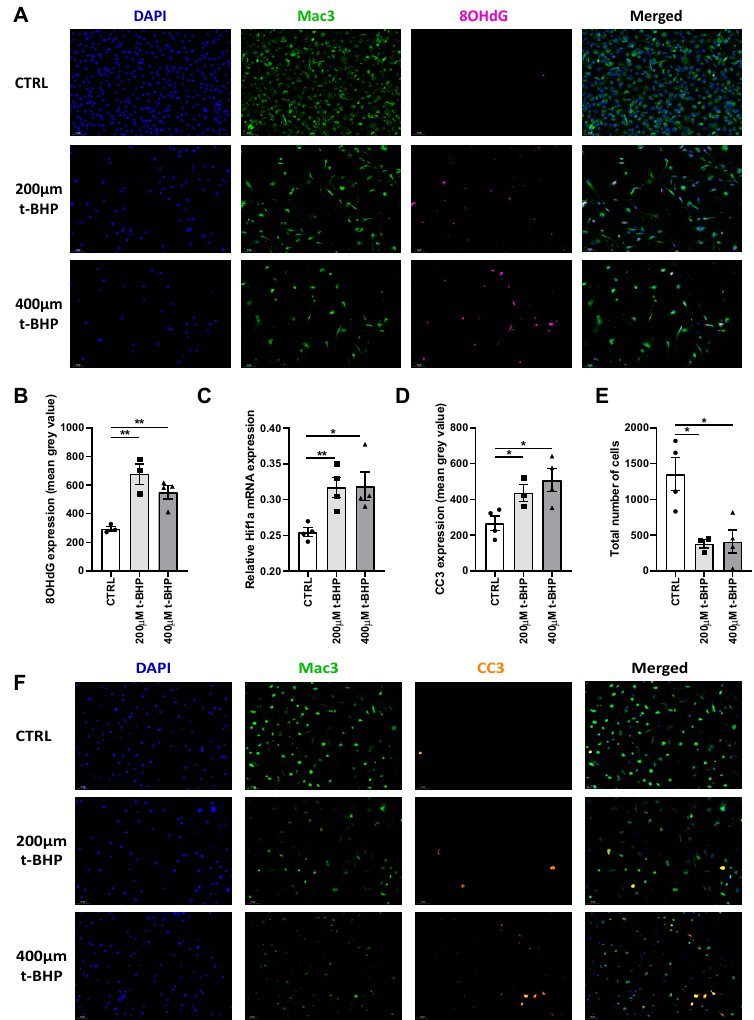
Figure 9. ROS induces DNA damage and apoptosis on in vitro bone marrow macrophages (BMM) ( A ) Representative pictures of CTRL BMM and BMM treated with 200 or 400 μ m t-BHP respectively are shown. Examples images stained for DAPI (blue), Mac3 (green) and 8OHdG (magenta) as well as a merged image are shown per each condition tested. ( B ) Quantification of 8OHdG expression as mean intensity is shown. ( C ) Total mRNA expression of Hif1a relative to Hprt. ( D ) Quantification of CC3 expression as mean intensity is shown. ( E ) Quantification of total amount of cells per condition tested expressed as total amount of positive DAPI nuclei. ( F ) Representative pictures of CTRL BMM and BMM treated with 200 or 400 μ m t-BHP respectively. Examples images stained for DAPI (blue), Mac3 (green) and cleaved caspase 3 (CC3) (orange) as well as a merged image are shown per each condition tested. Data are presented as mean ± SEM. * p < 0.05, ** p < 0.01; by two-sided Student’s t